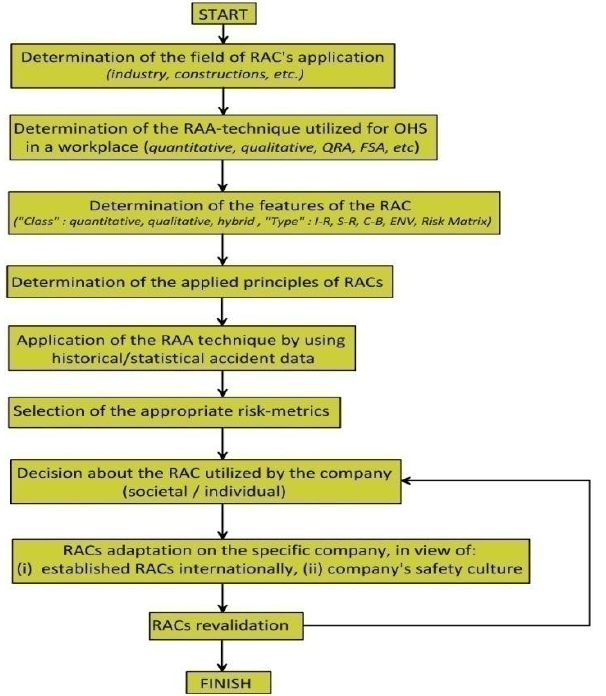
Figure 15. A flow diagram that illustrates the subphases of the formation of new